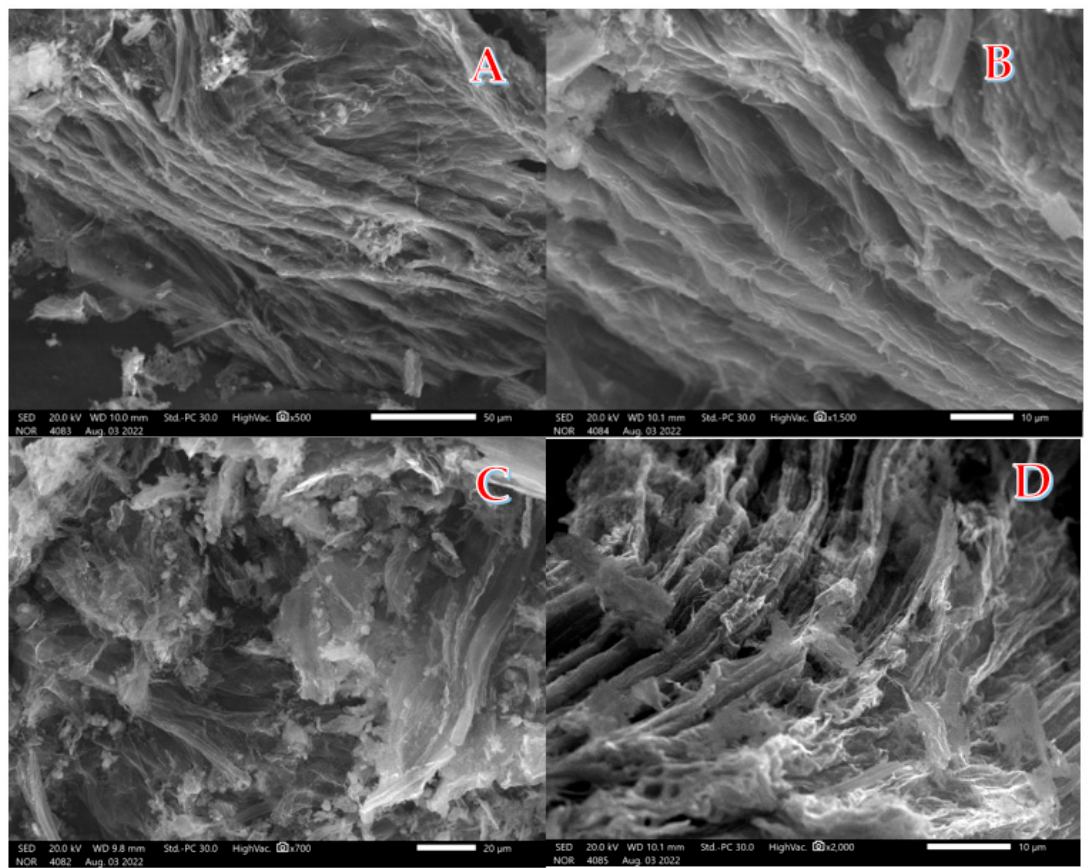
Figure 1. Two magnification SEM images of the powder produced from hydrothermal treatment using 3.0 M KOH at 150 °C for 6 h and calcined at 800 °C; ( A , B ), and at 1.0 M KOH at 170 °C for 3 h and calcined at 600 °C; ( C , D ).